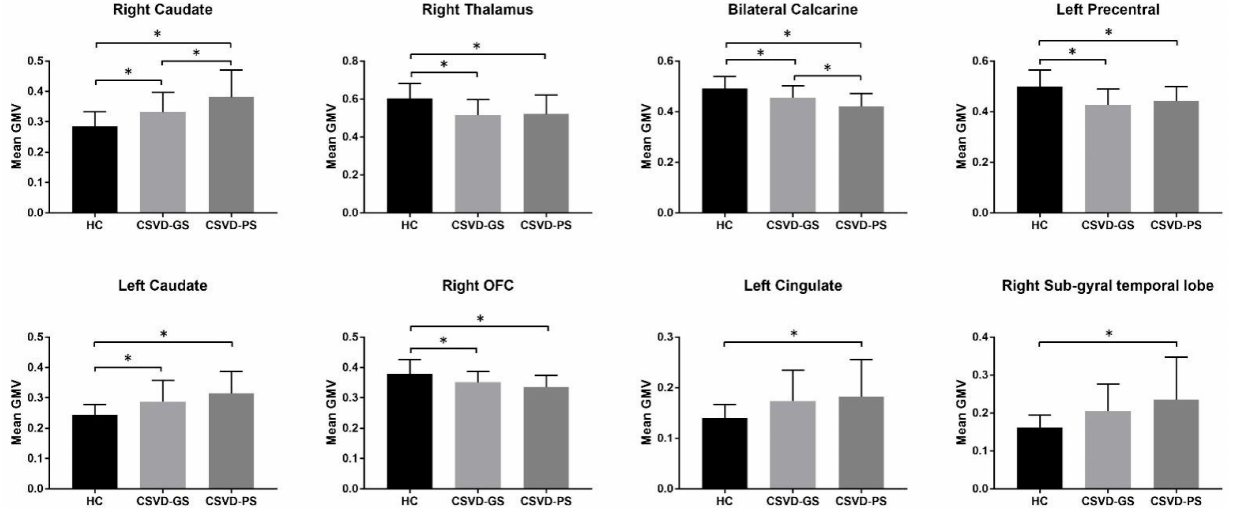
Figure 3. ROI post hoc tests. X-axis represents three groups of subjects; Y-axis indicates the mean GMV of each ROI. * Significant at p < 0.05 (Bonferroni corrected). ROI—region of interest; GMV— gray matter volume; OFC—orbitofrontal cortex; CSVD—cerebral small vessel disease; HC—healthy controls; GS—good sleepers; PS—poor